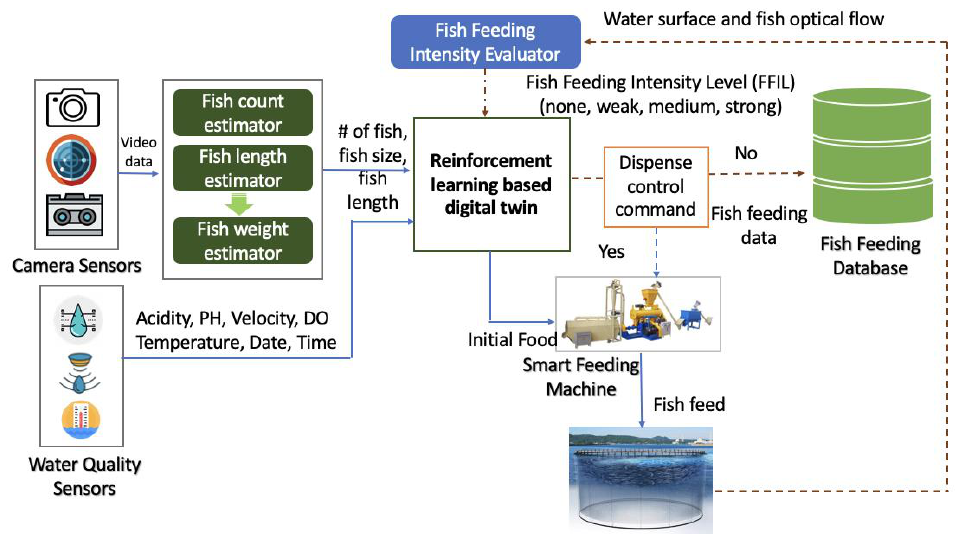
Figure 3. The reinforcement learning-based digital twin for controlling the smart feeding machine to minimize the usage of fish food.